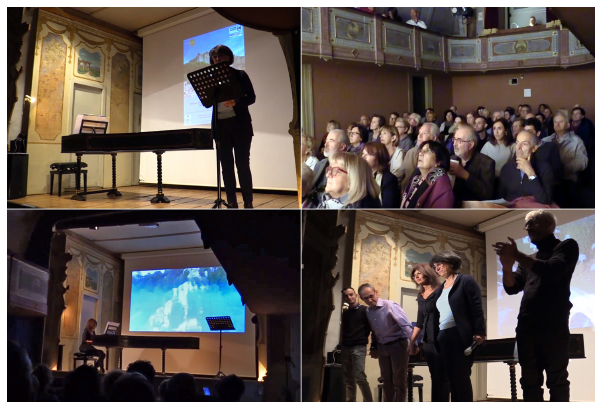
Figure 16. Live show in the theatre of the prominent Renaissance fortress of Sassocorvaro